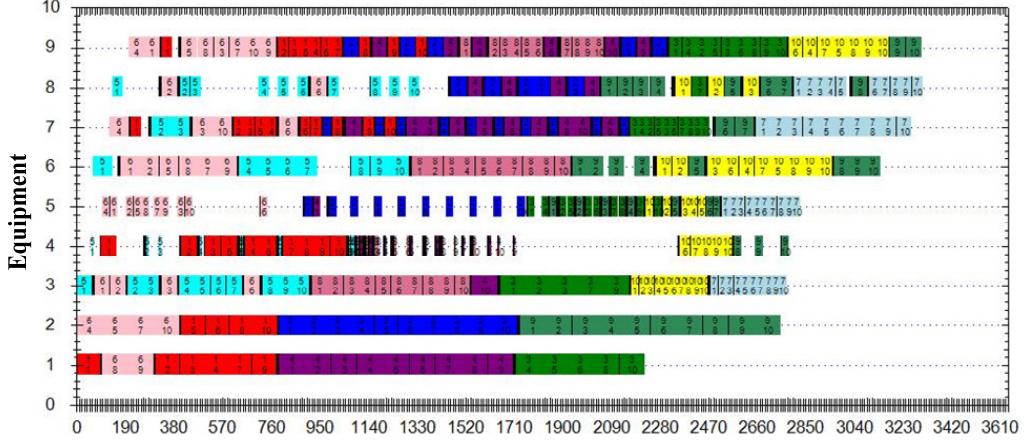
Figure 9. Static scheduling Gantt chart.